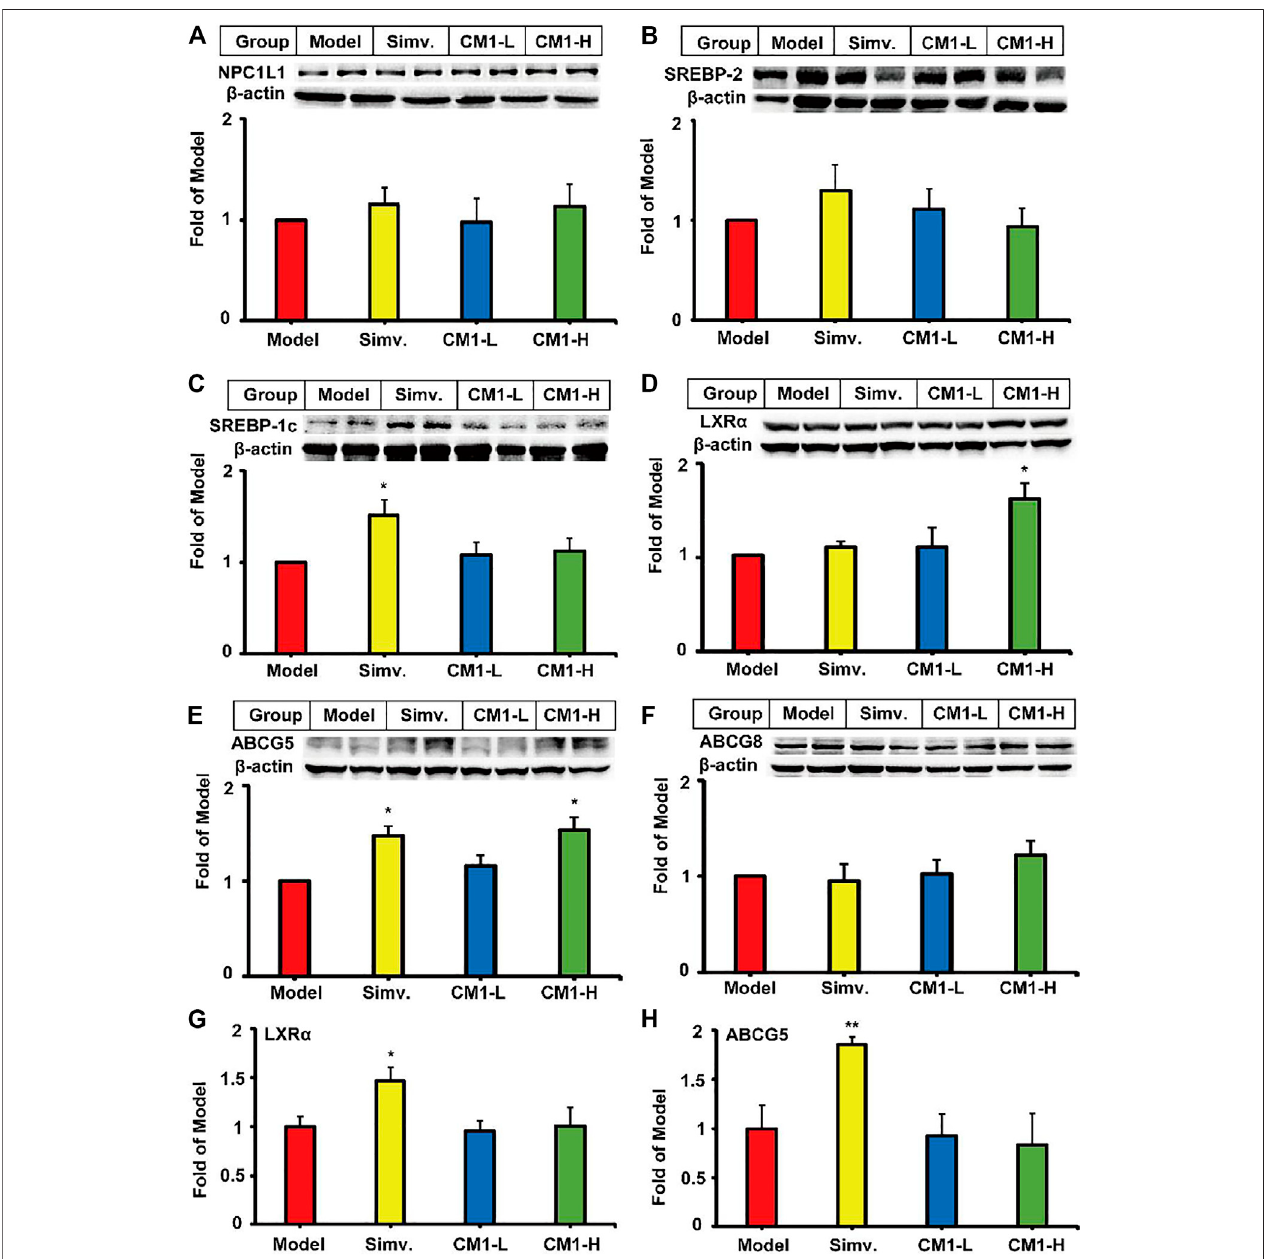
FIGURE6| EffectofCM1ontheexpressionoflipidmetabolismrelatedgenesandproteinsinthesmallintestineoftheLDLR (-/-) mice( n ≥ 4).Proteinexpressionand densitometric quanti fi cation. (A) , NPC1L1; (B) , SREBP-2; (C) , SREBP-1c; (D) , LXR α ; (E) , ABCG5; (F) , ABCG8; (G) , mRNA expression of LXR α ; (H) , mRNA expression of ABCG5. *means p < 0.05 vs . Model, and **means p < 0.01 vs . Model.